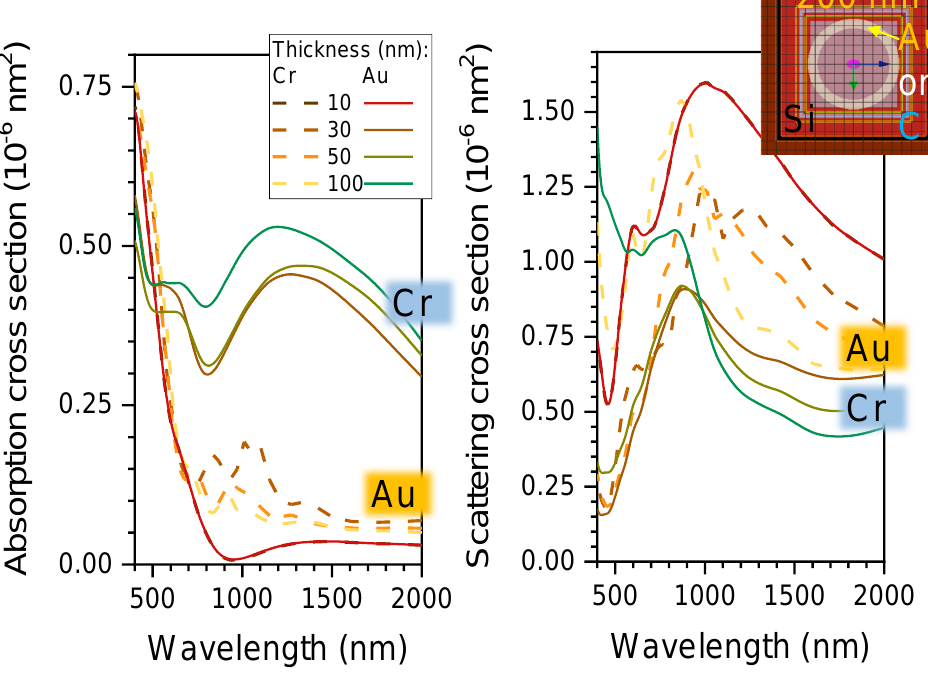
Figure A2. FDTD simulations (Lumerical ANSYS). Cross sections σ ab and σ sc of 200-nm-wide Cr or Au (dashed-lines) rings of 950 nm diameter and different thicknesses from d = 10 to 100 nm. Material properties are taken from Lumerical